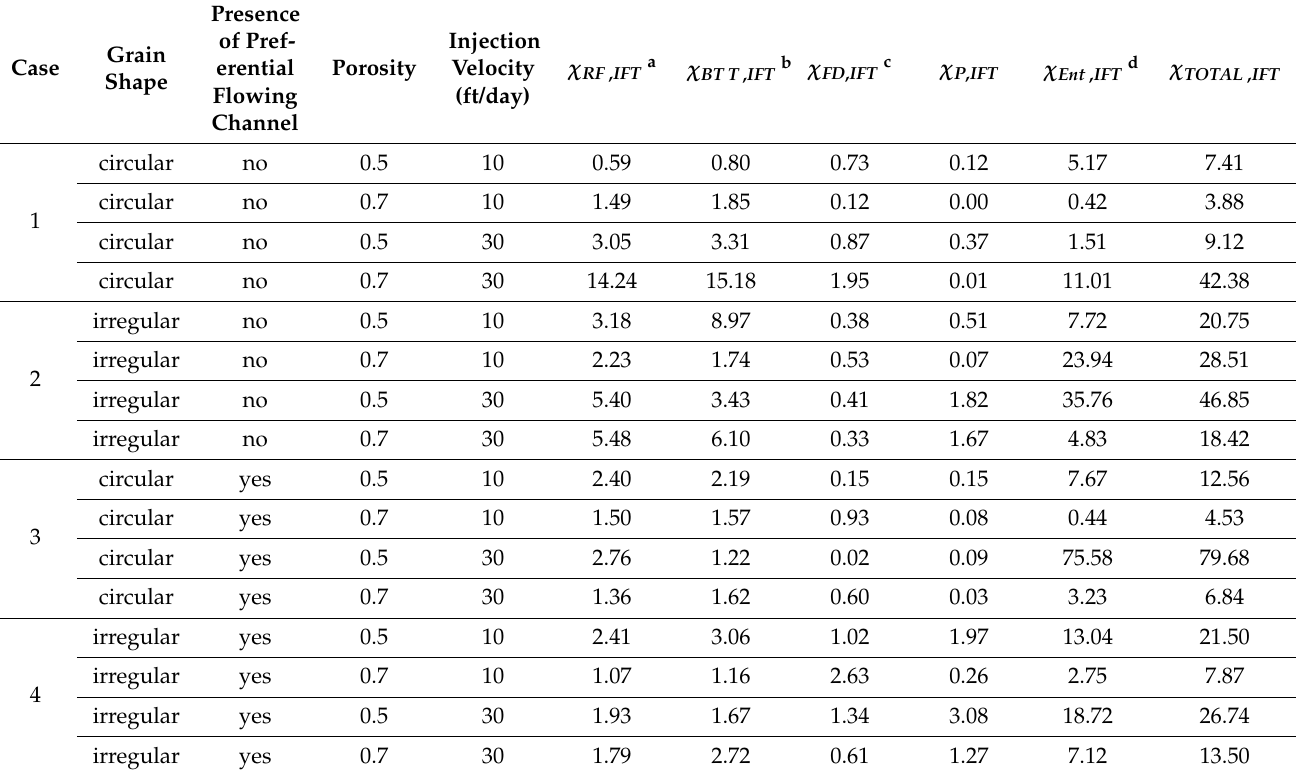
Table 6. Normalized sensitivity coefficients χ i,IFT obtained from the CFD